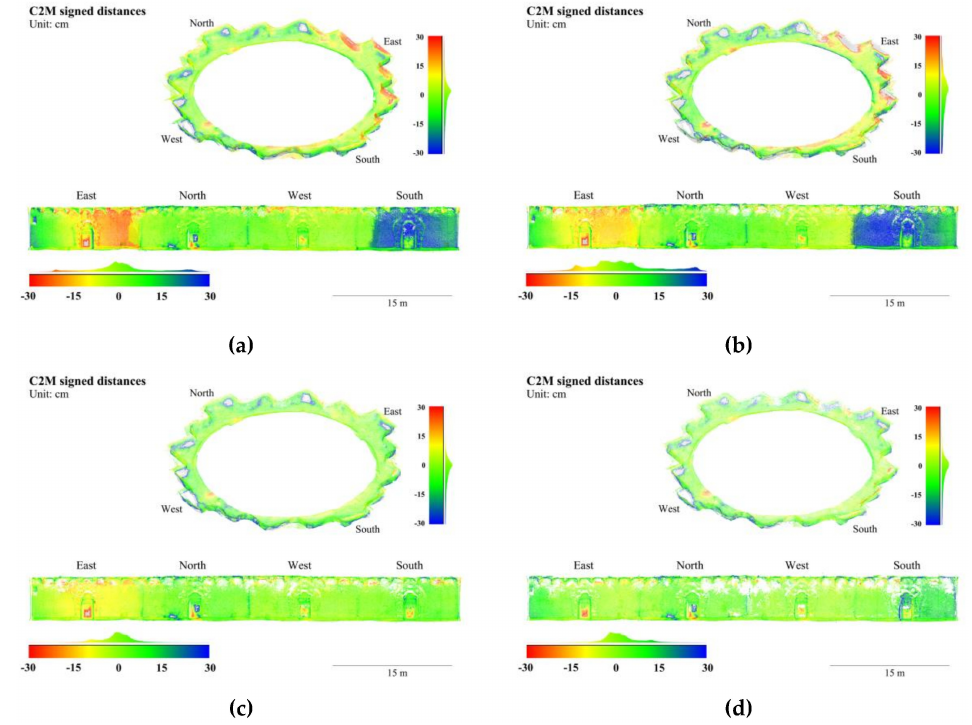
Figure 7. 3D points colored in cloud-to-mesh (C2M) signed distances to the GTM with variable baselines of the Stupa. ( a ) B 10 ; ( b ) B 20 ; ( c ) B 30 ; and ( d ) B 40